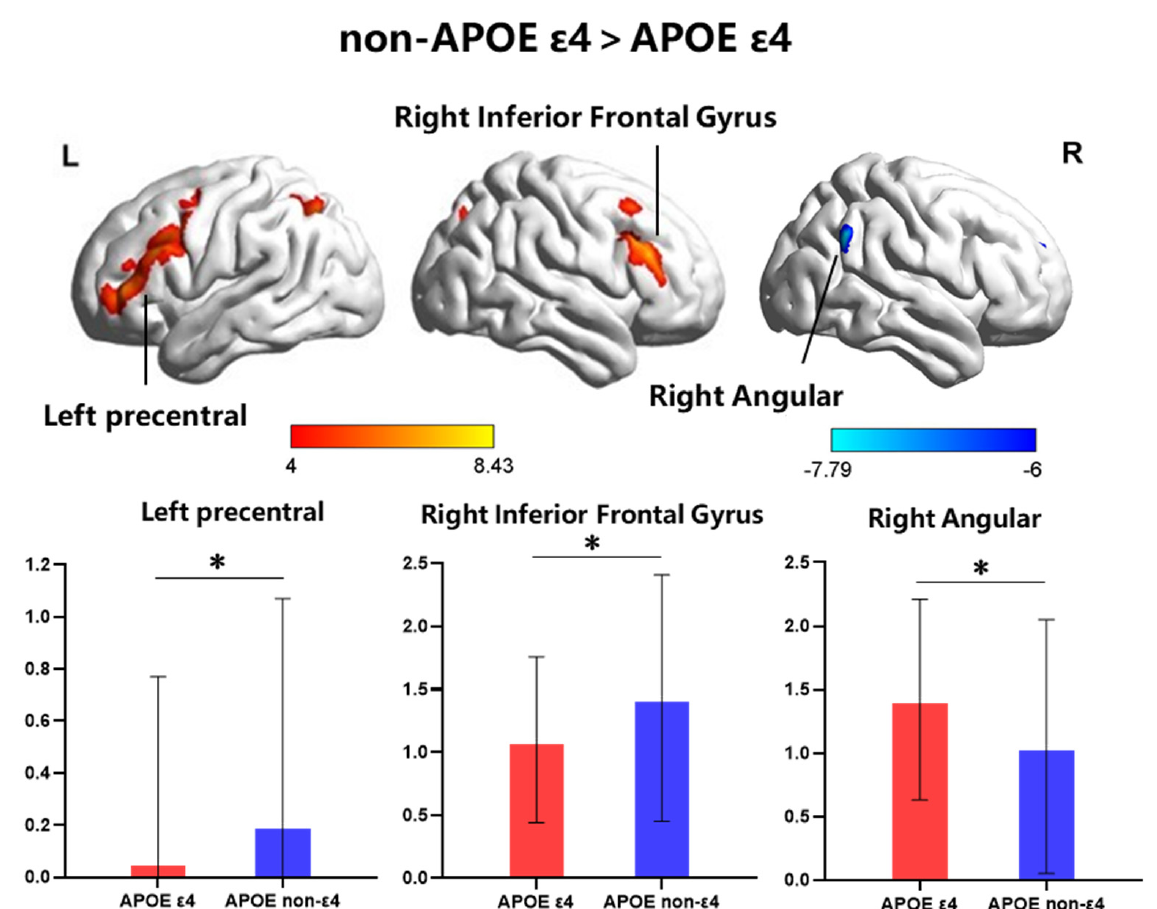
Figure 3. The significant group difference in functional connectivity within the LFP network. The x -axis represents groups and the y -axis represents the functional connectivity. In the left precentral and right triangle inferior frontal gyrus, the APOE ε 4-carrier group showed decreased connectivity to the APOE non- ε 4 group. However, in the right angular gyrus, the APOE ε 4-carrier group showed increased connectivity than APOE non- ε 4 group. *, p < 0.05, FWE corrected. The results showed that within the frontal-parietal network, significant FC of the left precentral gyrus × APOE ε 4-status interaction effects were found in memory (Digit span-backward, p = 0.03, uncorrected), language (CVFT, p = 0.02, uncorrected) and processing speed (Stroop B time, p = 0.02, uncorrected) and significant FC of the right angular × APOE ε 4-status interaction effects were found in memory (Digit span-backward, p = 0.02, uncorrected). Further analysis revealed that the FC of the left precentral gyrus was significantly correlated with memory (Digit span-backward, r = − 0.50, p = 0.03), language (CVFT, r = − 0.54, p = 0.02) and processing speed (Stroop B time, r = 0.53, p = 0.02) only in the ε 4-carrier group. The FC of the right angular was significantly correlated with memory (Digit span-backward, r = 0.53, p = 0.02) only in the ε 4-carrier group, and there was no significant correlation between the FC and other cognitive performance ( p > 0.05). There was no significant correlation between the FC of the right inferior frontal gyrus and cognitive performance in each group ( p > 0.05) (Figure